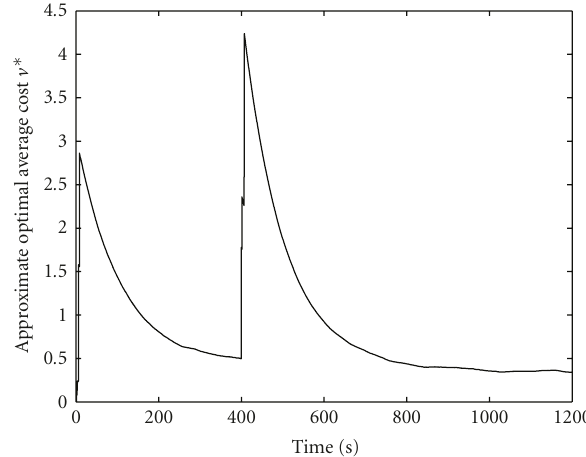
Figure 10: Curve of (cid:12) v in the second